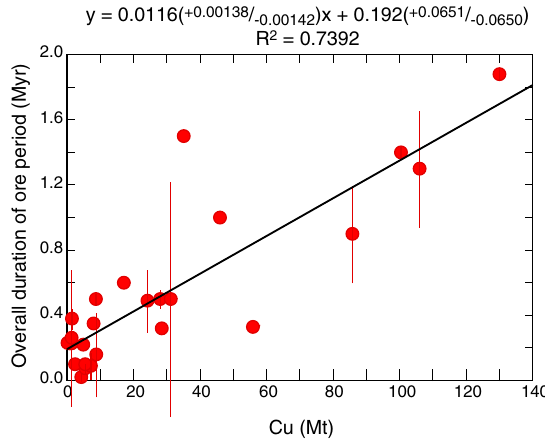
Fig. 3 Relationship between the overall duration of ore period and Cu endowments. Plot showing the relationship between the overall duration of the ore period (Myr) and Cu endowments (Mt) of porphyry copper deposits. The data from porphyry copper deposits (Cu Mt, ore durations and associated 1 SD uncertainty bars) are from Supplementary Data 1. Overall durations of the ore periods are the calculated differences between the oldest and youngest ages of recorded magmatic-hydrothermal mineralizing events with their propagated uncertainties where uncertainties on the above ages are available. The equation reported is the best- fi t linear regression between the two variables with associated uncertainties for the slope and interval within which such magma volume is transferred from the mid- to lower crust accumulation zone (i.e., >~15 km depth) into the upper crust (i.e., 5 – 15 km depth) where Cu is precipitated. The ratio between these two parameters gives the average magma injection rate corresponding to a speci fi c Cu endowment.